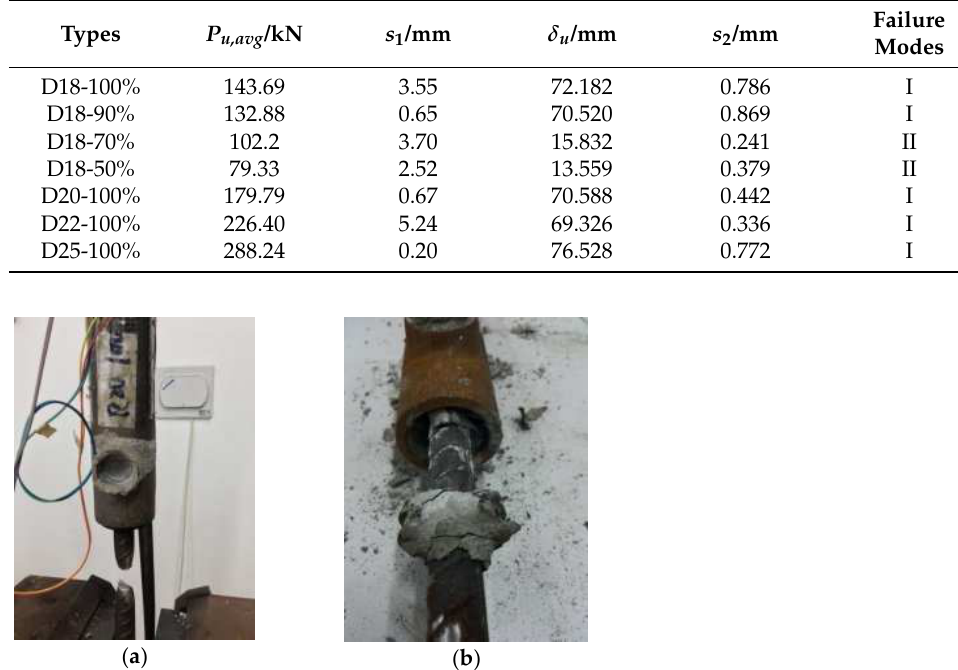
Figure 7. Load-displacement curves for fully compact GSS connectors.